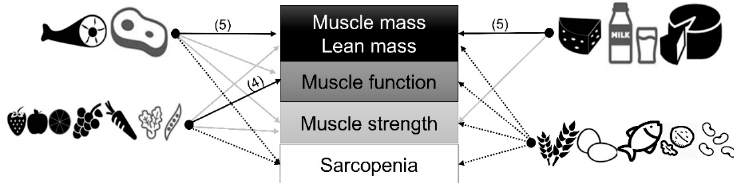
Figure 2. Myoprotective foods and muscle-related outcomes: summary of evidence. Summary of authors’ evaluation of the strength of evidence for the role of whole foods in muscle health in older adults in observational and intervention studies. The strength of evidence was determined based on the number of studies reporting statistically significant associations or effects, and the study quality (risk of bias assessments). The synthesis of findings showed strong and consisted evidence for the role of lean red meat and total dairy (including non-liquid dairy) in muscle mass or lean tissue mass in both observational and intervention studies (black bold line; red meat: 5 studies [21,22,36,40,45] (3 low, 1 medium, and 1 high risk of bias); dairy: 5 studies [37–39,46,47] (3 low, and 2 medium/somewhat risk of bias)). Higher intake of fruit and vegetables was associated with better muscle function in observational studies (black bold line; 4 studies [25,27,30,35] (2 low and 2 medium risk of bias)). There was moderate evidence for the role of these foods in muscle strength and sarcopenia (grey bold line; red meats: 3 studies [40,44,45] (1 low and 2 high risk of bias); fruit and vegetables: 4 studies [26,27,37,43] (2 low, 1 medium/somewhat, 1 high risk of bias), and dairy: 3 studies [37,46,47] (2 low and 1 medium/somewhat risk of bias)), and limited or inconclusive evidence for the benefits of other whole foods (e.g., cereal, fish, soy products) for muscle health in older adults (dashed black line; 9 studies [29,30,32,34,35,41,46–48] (3 low, 5 medium/somewhat, and 1 high risk of bias)). Several studies have used multiple whole foods and muscle-related outcomes.